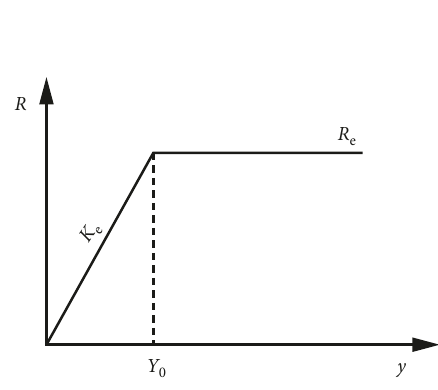
Figure 12: Resistance-deflection